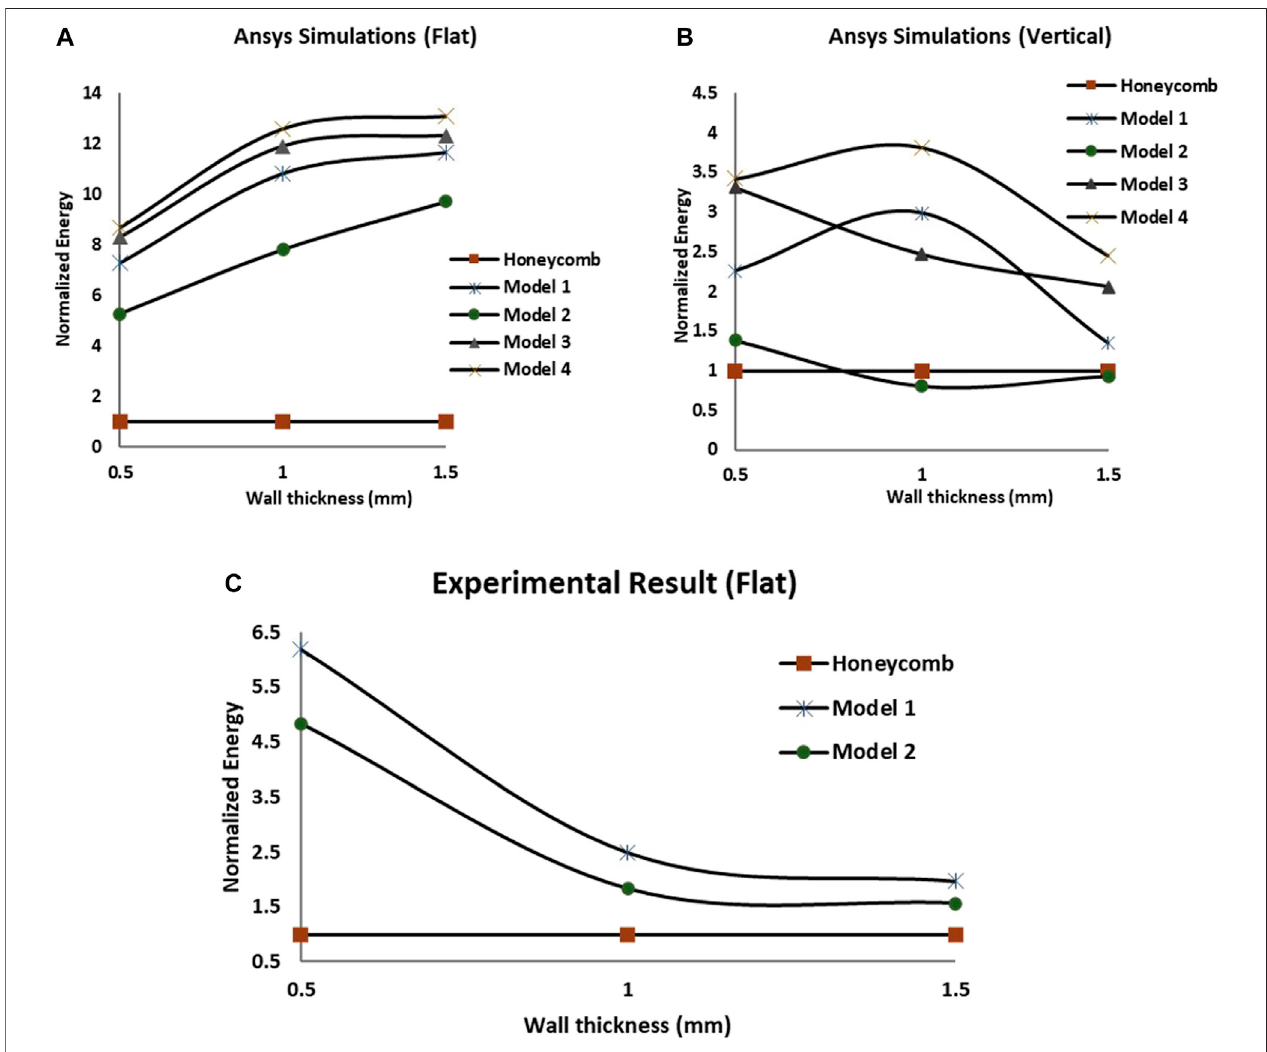
FIGURE10| Numerical simulations forlowvelocityimpacttest on various optimal cellular structuresin (A) fl at, (B) verticalorientations and (C) experimentalresults in fl at orientation.